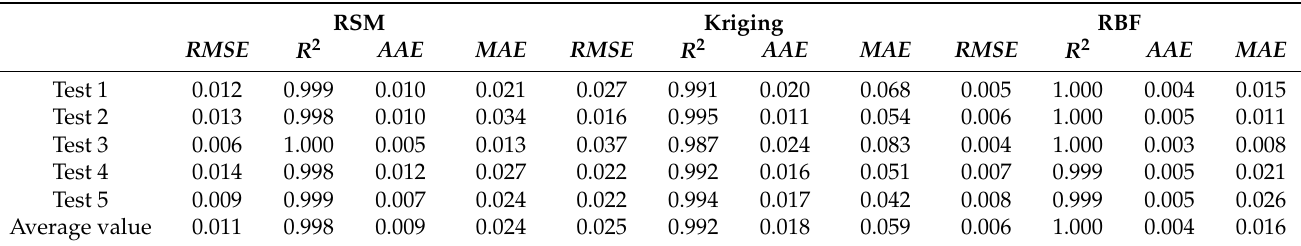
Table 4. Validation results and partial Pareto optimal solutions based on NSGA-II algorithm.